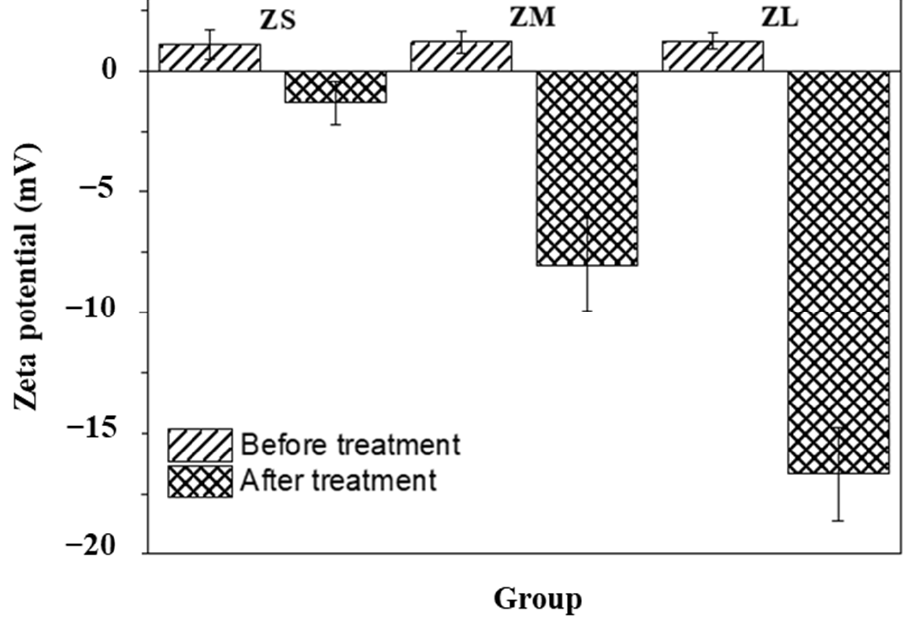
Figure 4. Zeta potentials of zirconia particles before and after silane coating.